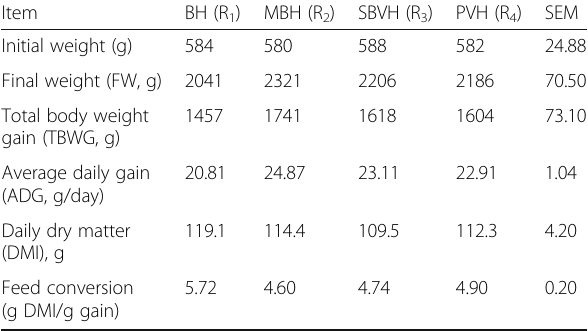
Table 4 Growth performance of the experimental groups